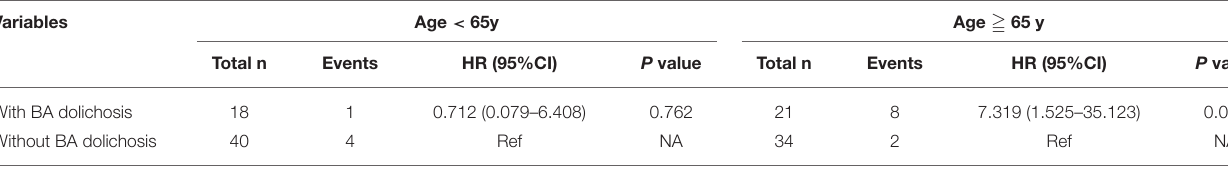
TABLE 3 | Subgroup analysis stratified by age.